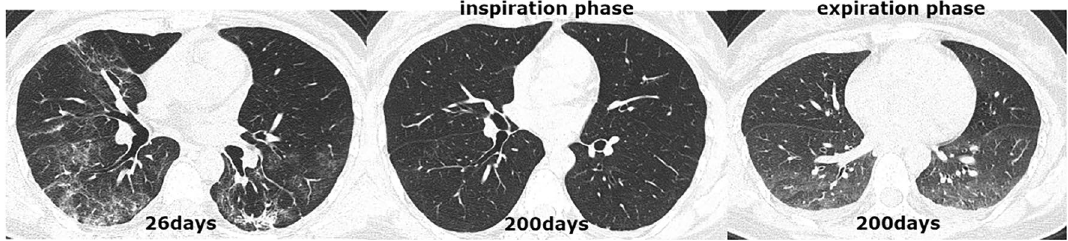
Figure 2. CT scan series in a 40-year-old COVID-19 patient with abnormal DL CO (74.6%) at the 6-month follow-up. ( a ) Transverse CT scan obtained 26 days after the onset of symptoms showed diffuse ground-glass opacities coexisting with consolidations in both lungs. ( b ) Scan obtained during full inspiration on day 200 demonstrated complete resolution of lung abnormalities. ( c ) Scan obtained during expiration at 200 days showed substantial air